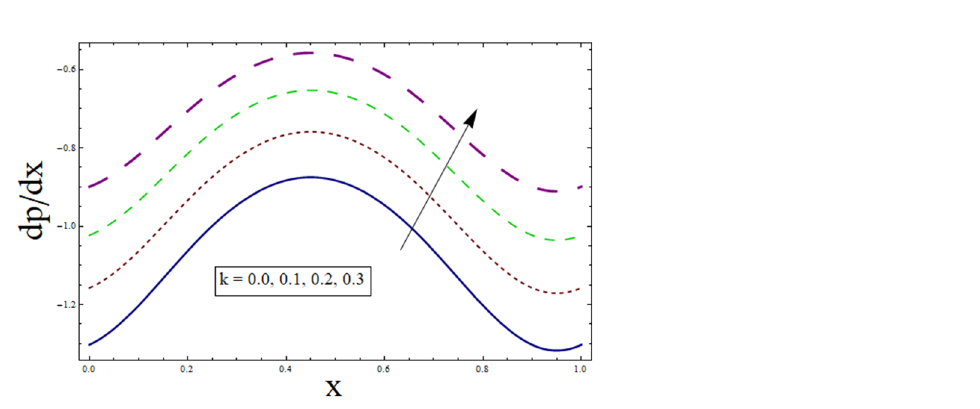
Figure 19. dp/dx for k